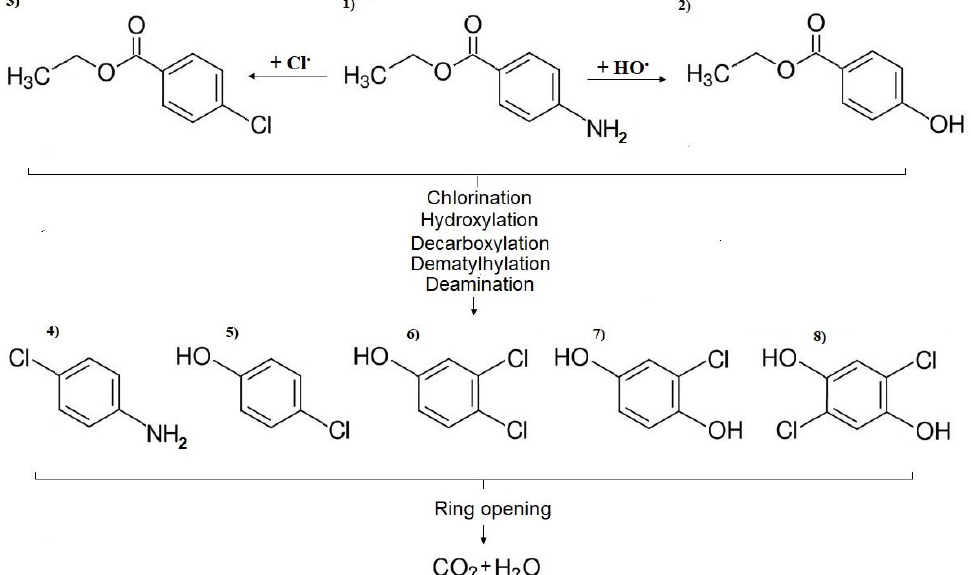
9-Chloroacridine results from the substitution of chlorine to the phenolic ring (Figure 7). Further